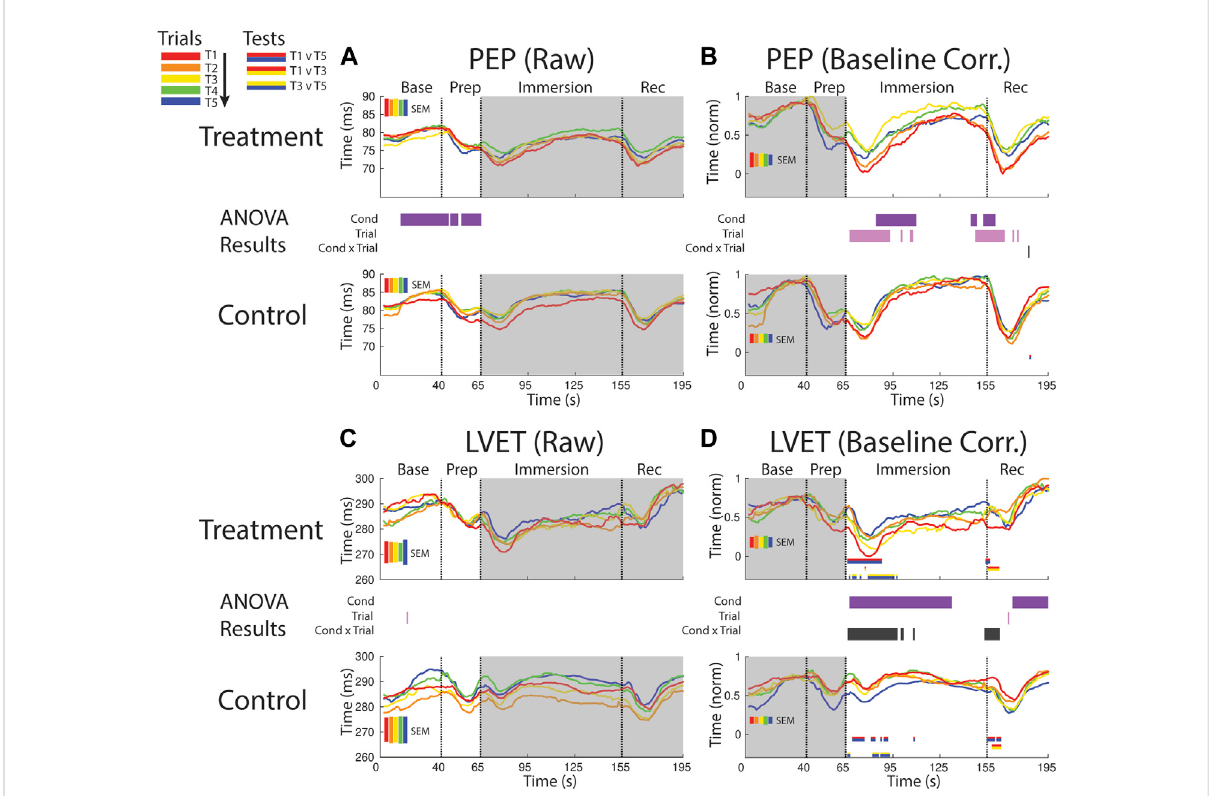
FIGURE 5 Effects of treatment and repeated trial exposure on sympathetic drive [PEP; (A , B)] and cardiac timing [LVET; (C , D)] . Pre-exposure and evoked stress effects are re fl ected in raw (left column) and baseline corrected/normalized (right column) plots, respectively. Each panel contains a separate plotfor thetreatmentandcontrolcondition,with themean responseacrossparticipantsineach repetitiontrial(T1-T5)represented ineachplotbya differentcolor(ROYGB).Horizontallinespositionedbetweentreatmentandcontrolplotsindicatestatisticallysigni fi cantANOVAmaineffectsof condition (dark purple), trial (light purple) and the condition x trial interaction (dark gray) at designated timepoints ( p null < 0.05). Horizontal red/blue, red/yellow and yellow/blue lines at the base of treatment and control plots respectively indicate statistically signi fi cant pairwise comparison results forT1vT5,T1vT3andT3vT5atthedesignatedtimepoints( p null < 0.05).Post-immersionrawdataandpre-immersionbaselinecorrectednormalized data are greyed out as these periods are not relevant to the pre-exposure/evoked stress analyses. The set of fi ve vertical error bars labelled SEM on each plot represent ±SEM of the data averaged over the time-course of